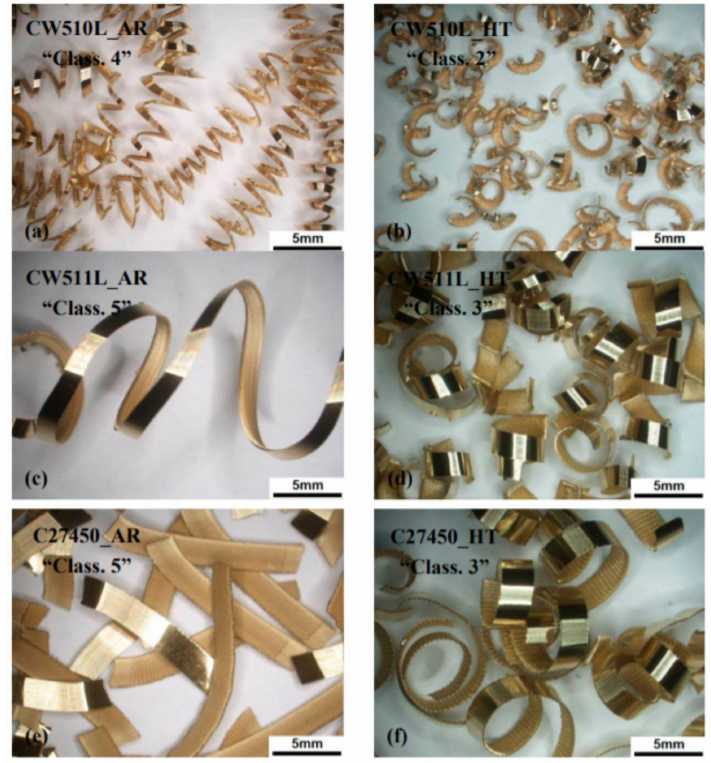
Figure 6. Chip morphology of the as-received (AR) and heat-treated (HT) CW510L-CuZn42 ( a , b ), CW511L-CuZn38As ( c , d ) and C27450-CuZn36 ( e , f ) brass alloys [25]. Note: the decrease in Class number denotes improvement in chip morphology